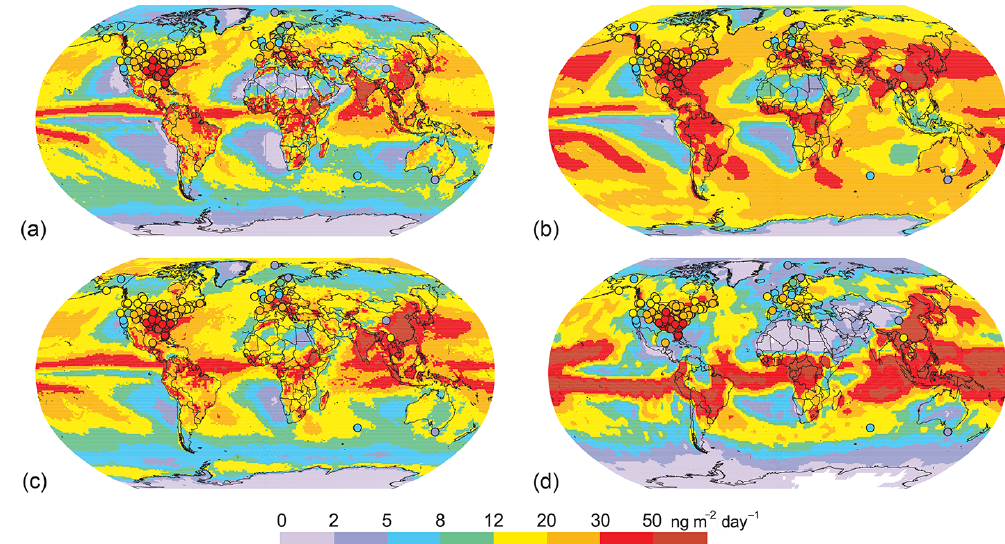
Figure 9. Spatial distribution of wet deposition flux in 2013 simulated according to the BASE case by four global models: (a) GLEMOS, (b) GEOS-Chem, (c) GEM-MACH-Hg, and (d) ECHMERIT. Circles show observed values in the same color scale.